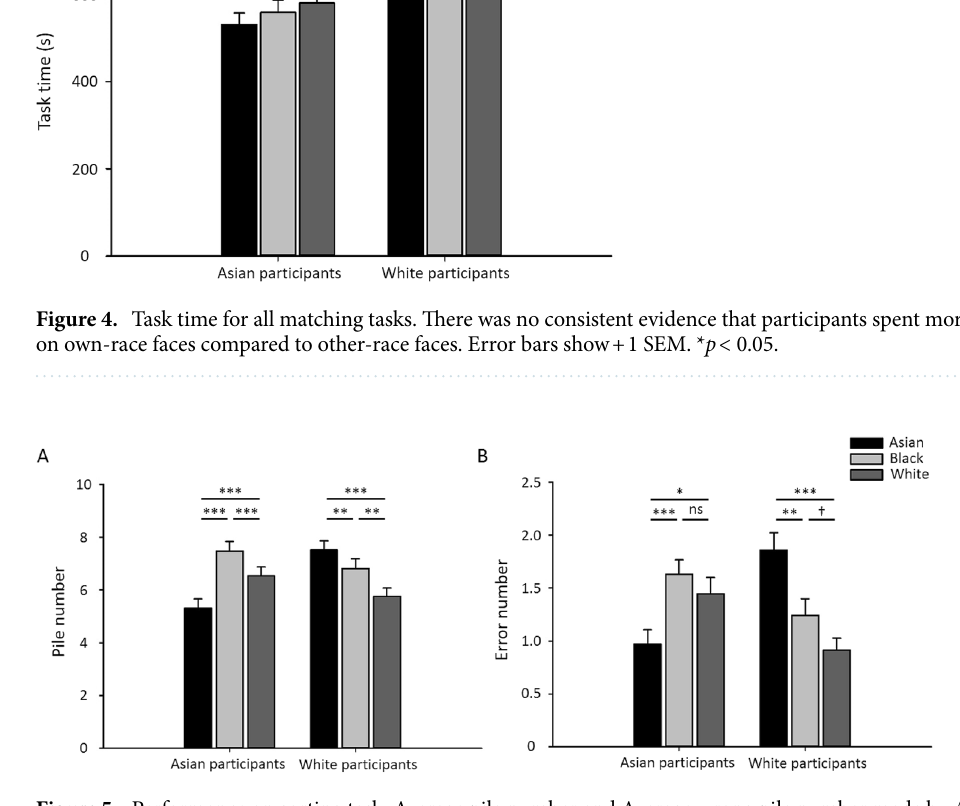
Figure 5. Performance on sorting task. Average pile number and Average wrong pile number made by Asian and White participant in Card sorting test. Error bars show + 1 SEM. *** p < 0.001, ** p < 0.01, * p < 0.05, †,